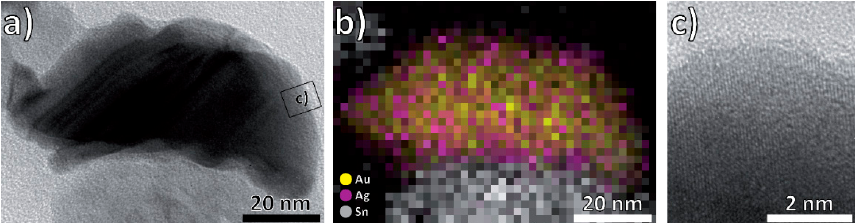
Figure 5. ( a ) BF (Bright-field) images of a representative Au/Ag nanoparticle; ( b ) energy dispersive X- ray (EDX) map of the same particle, showing an accumulation of Ag at the surface; ( c ) HRTEM image of the nanoparticle surface.